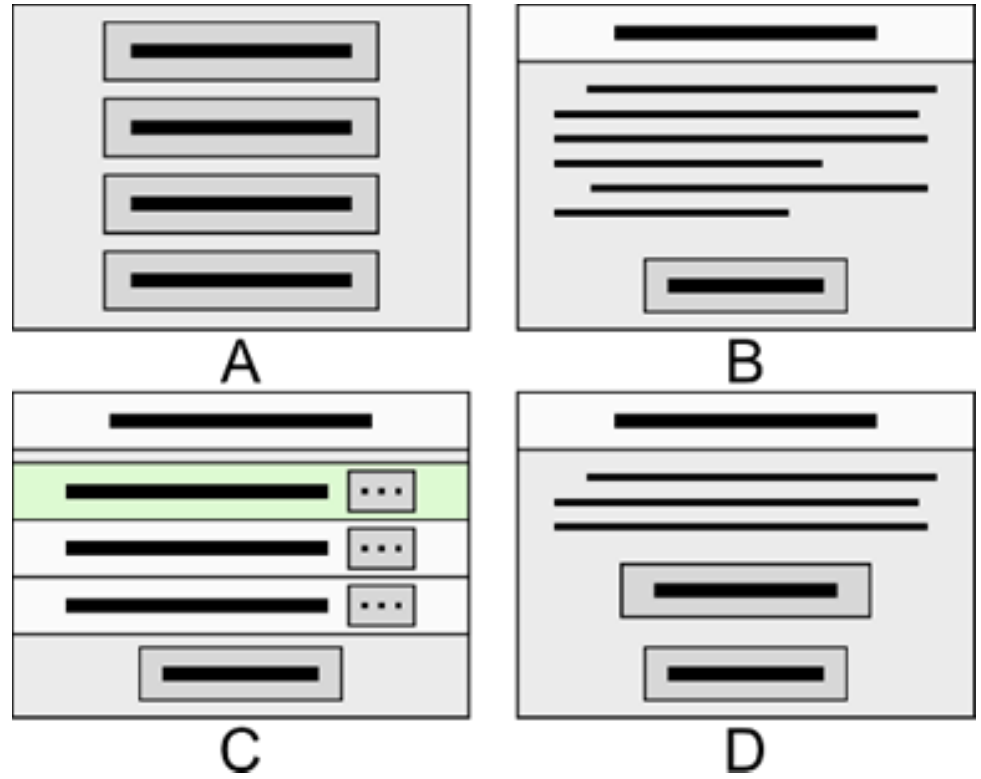
Figure 4. Script UI window layouts. Initial interface window ( A ), script and task description window ( B ), task window ( C ), and results window ( D